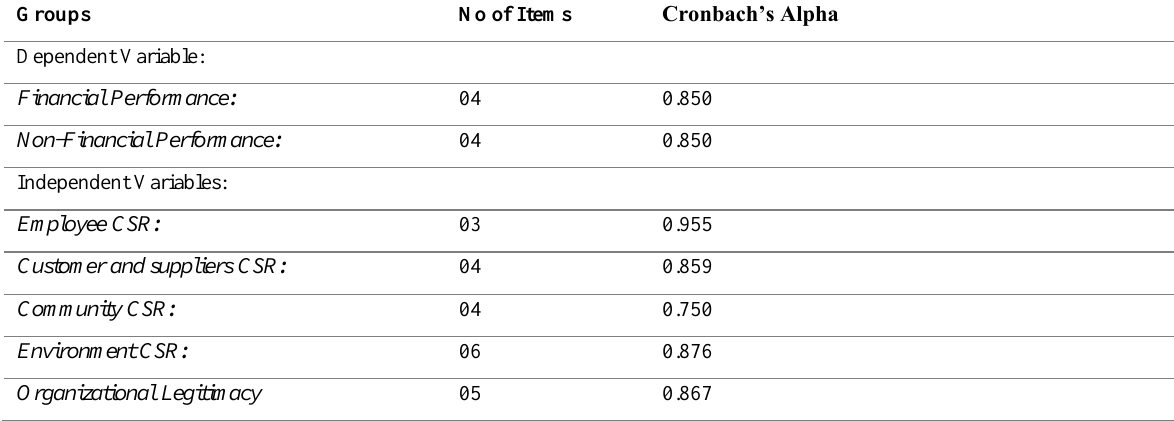
Table 6: Reliability Analysis of